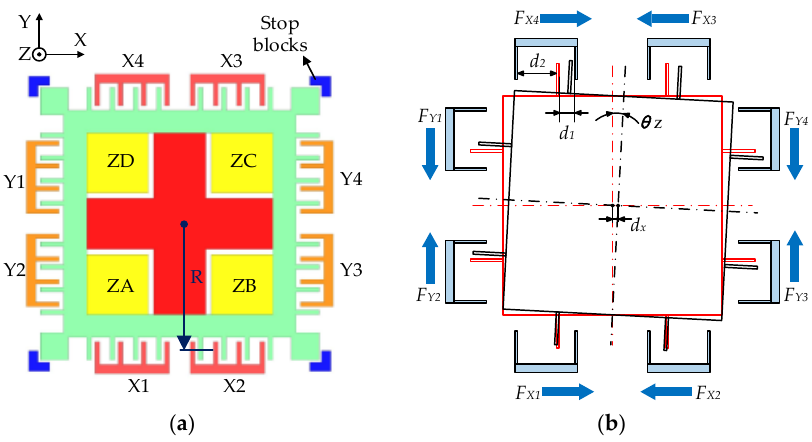
Figure 4. Top view of the electrodes pattern: ( a ) layout of the electrodes and stop blocks; and ( b ) the direction of the electrostatic force when the PM has a clockwise rotation around the z -axis and a translation along the x -axis. Table 1. Lateral gaps between eight sets of comb tooth and their neighboring electrodes.